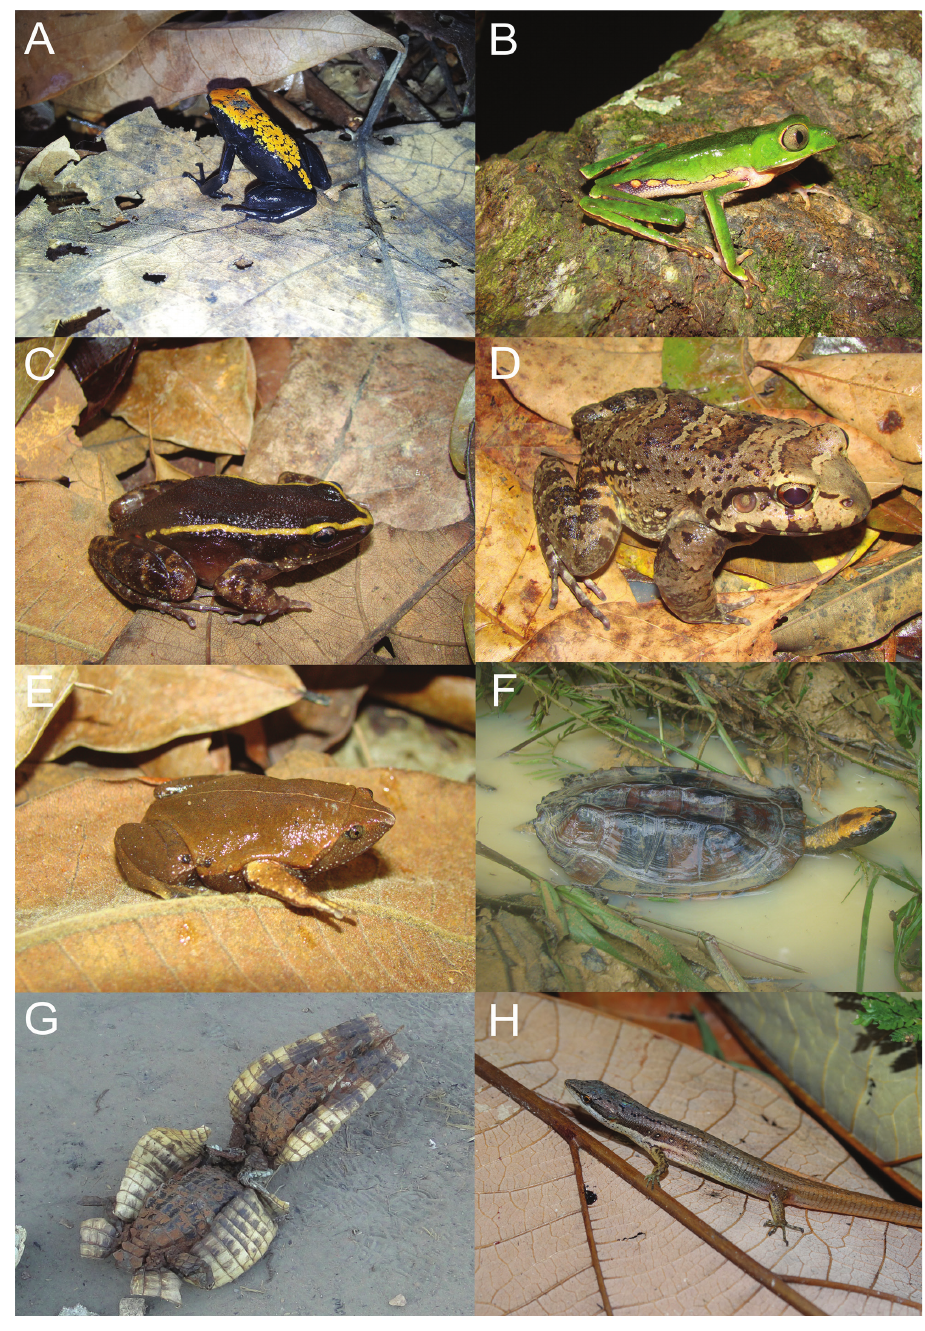
Figure 3. Some amphibians and reptiles recorded in the Gurupi Biological Reserve, Maranhão, Brazil. A Adelphobates galactonotus B Phyllomedusa vaillanti C Lithodytes lineatus D Leptodactylus paraensis E Ctenophryne geayi F Platemys platicephala G Paleosuchus trigonatus H Cercosaura argulus . Photo credit of P. trigonatus ( G ) belong to Eloisa Mendonça and M. A. de Freitas for